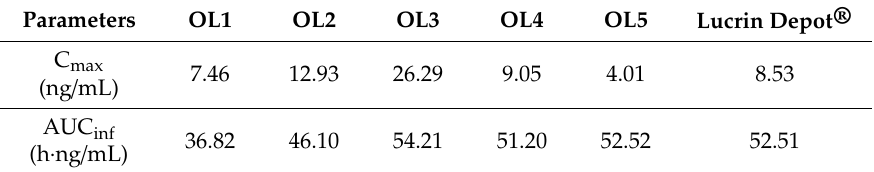
Table 3. Estimated PK parameters from the observed PK profile of Lucrin depot ® and the IVIVC-PK model predicted PK profiles of five electrosprayed microspheres.